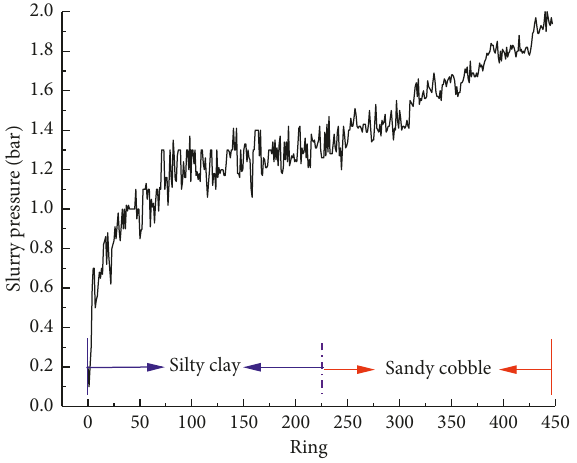
Figure 11: History of slurry pressure.